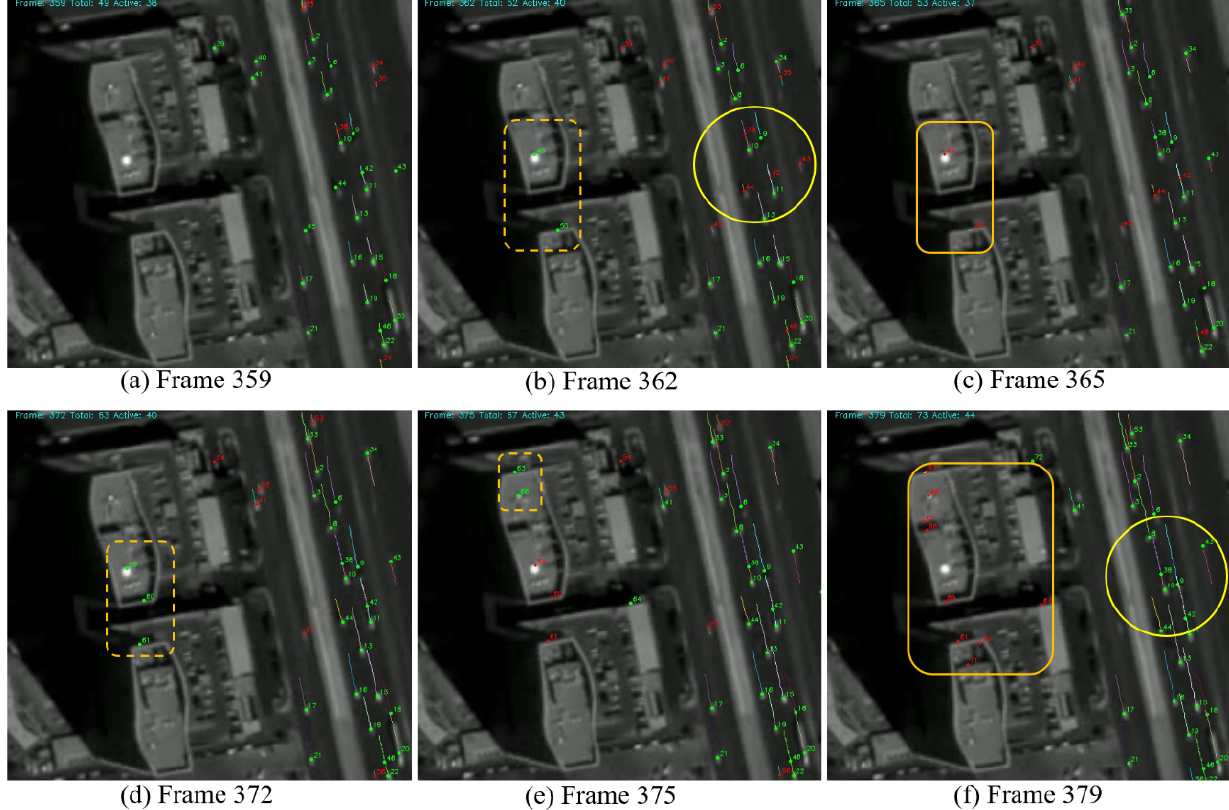
Figure 9. Short tracklets of noise from the tops of buildings. Green dots indicate true vehicles and red dots depict false ones in the current frame. red dots depict false ones in the current